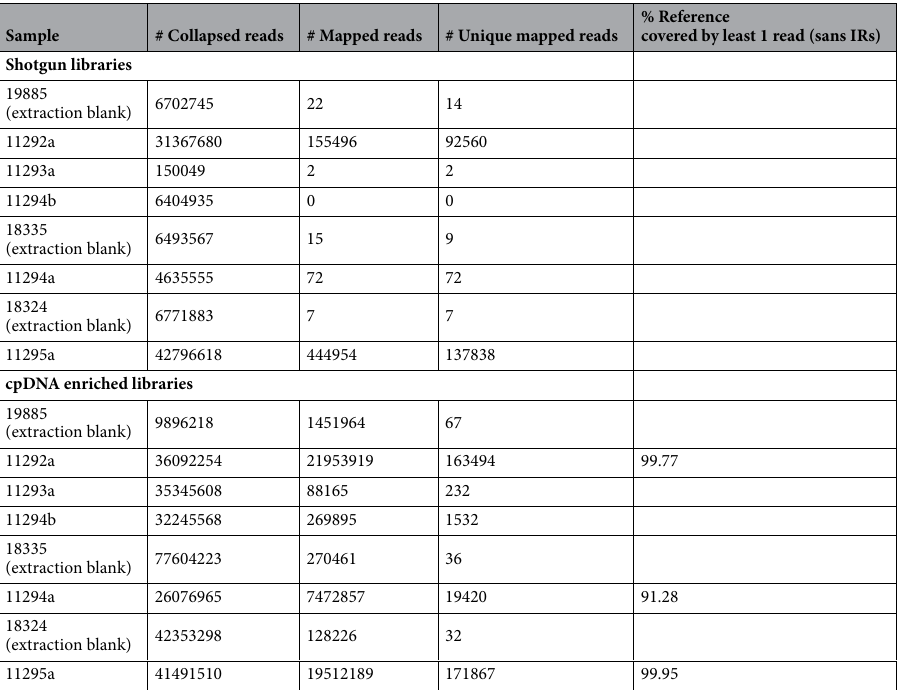
Table 3. Mapping statistics of shotgun and cpDNA enriched libraries. Mapping statistics of libraries made from Areni-1 millet grains and mapped to the Panicum miliaceum chloroplast reference genome (Genbank#: KU343177.1). Inverted repeat regions (IRs) are two nearly identical loci in the chloroplast genome where the short fragmented aDNA sequencing data could not accurately map (Fig. 2) and were excluded from any analysis. The IRs loci excluded represent bp: 81851 to 104489 and 117101 to 139826 of the reference, which is 139,826 bp in